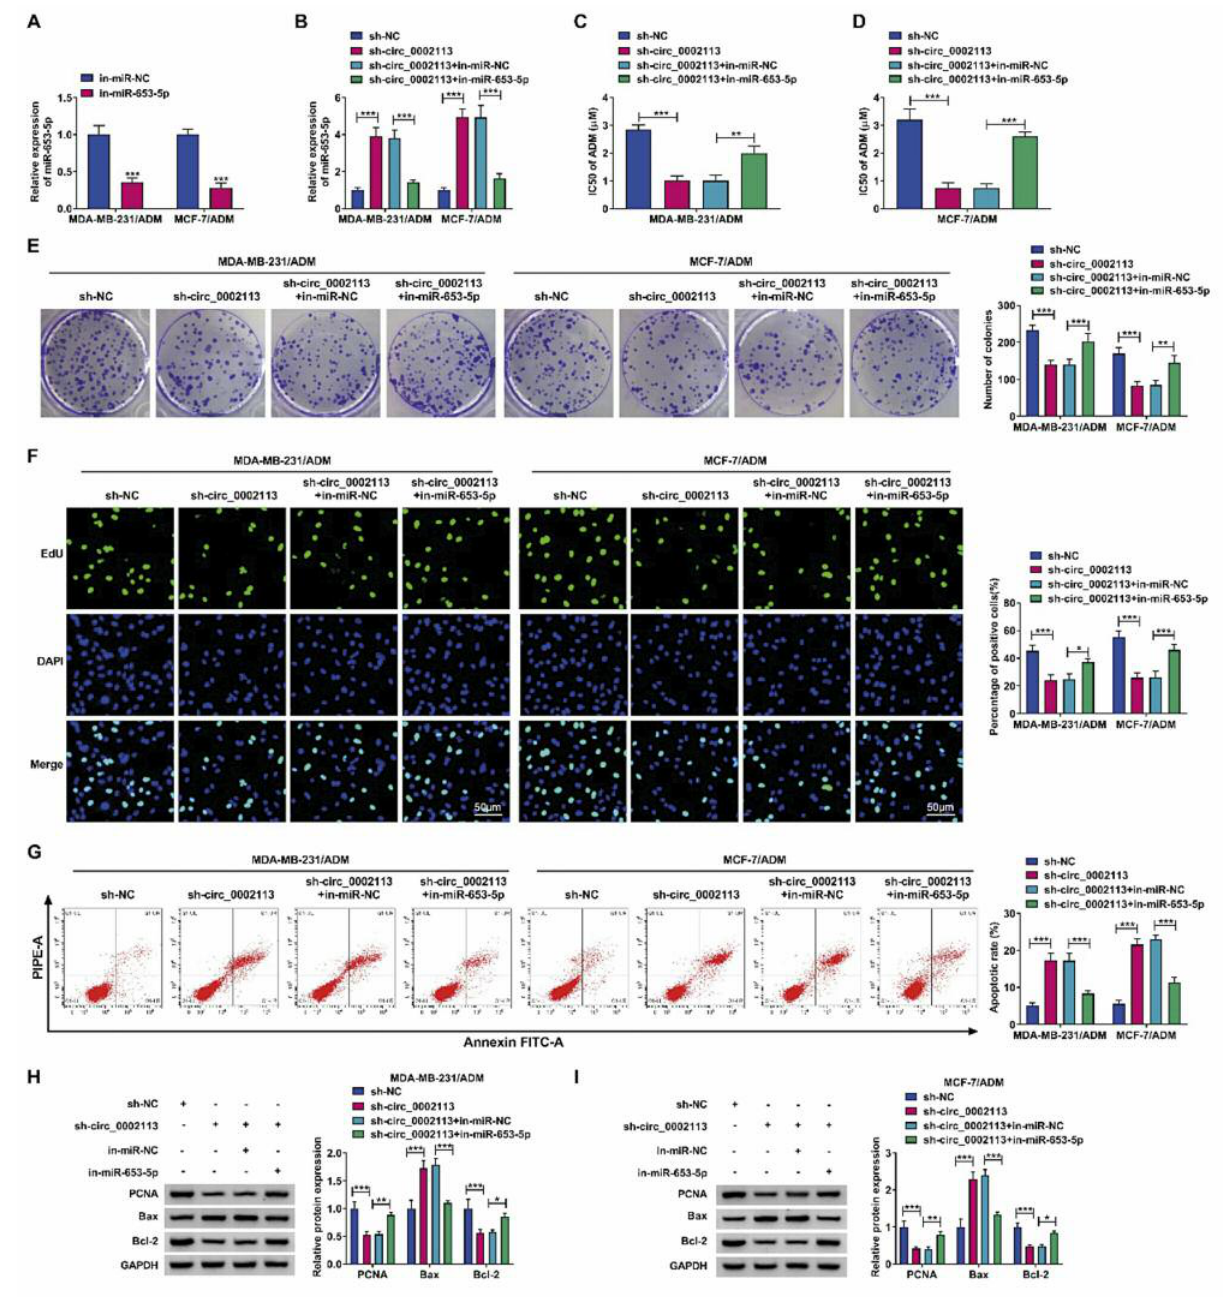
Fig. 5. Circ_0002113/miR-653-5p was involved in the regulation of ADM resistance and malignant behaviors of BC cells. (A) Transfection e ffi cacy of in-miR-653-5p was detected through RT-qPCR. (B-I) MDA-MB-231/ADM and MCF-7/ADM cells were transfected with sh-NC, sh-circ_0002113, sh-circ_0002113+in-miR-NC, or sh-circ_0002113+in-miR-653-5p. (B) The miR-653-5p expression was of ADM was determined through CCK-8 assay. (E-F) The proliferation ability was analyzed measured through RT-qPCR. (C-D) IC 50 through colony formation assay (E) and EdU assay (F). (G) Apoptotic cells were detected through flow cytometry. (H-I) PCNA, Bax and Bcl-2 levels were assayed through western blot. * p < 0.05, ** p < 0.01, *** p <